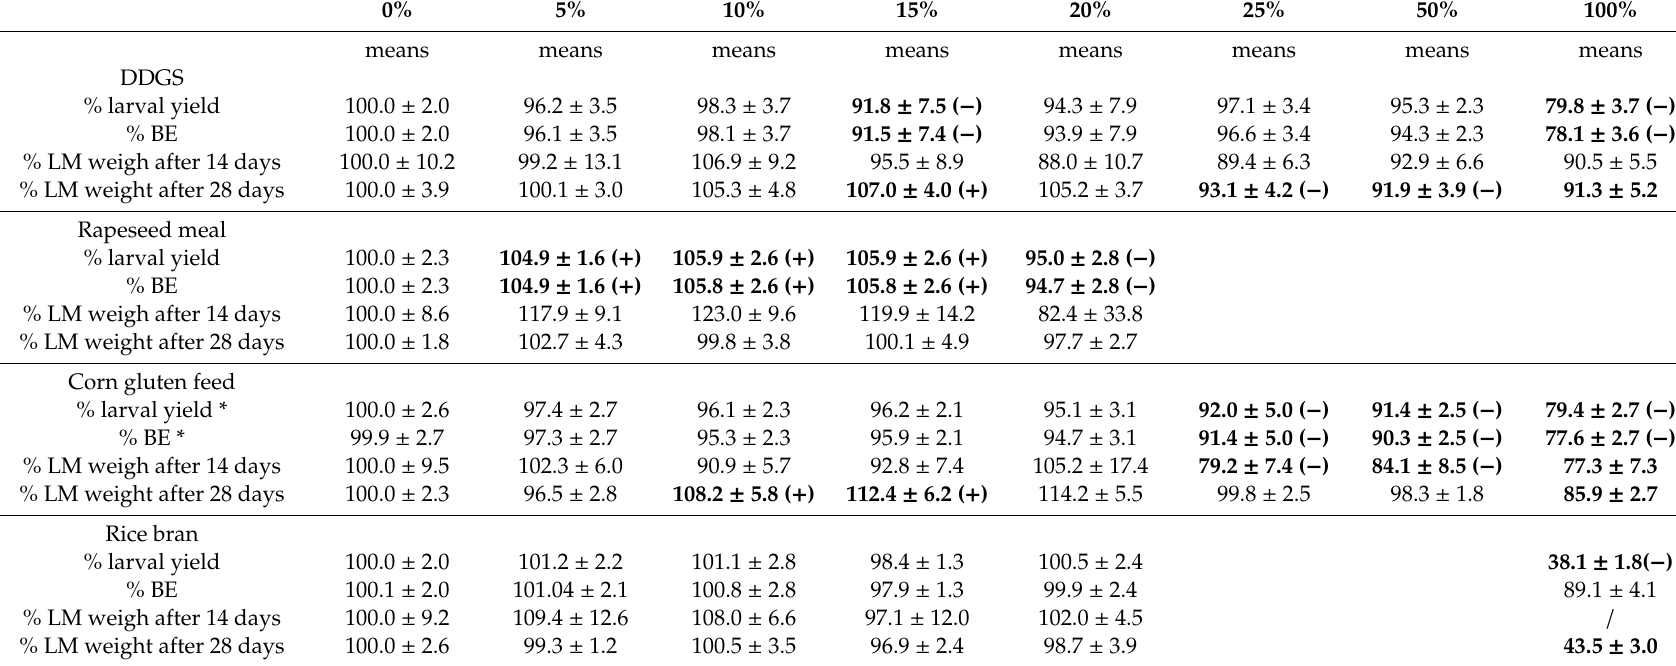
Table A1. Growth and performance of lesser mealworm (LM) on the selected side-streams with BG as a moisture agent. * ( n = 5).